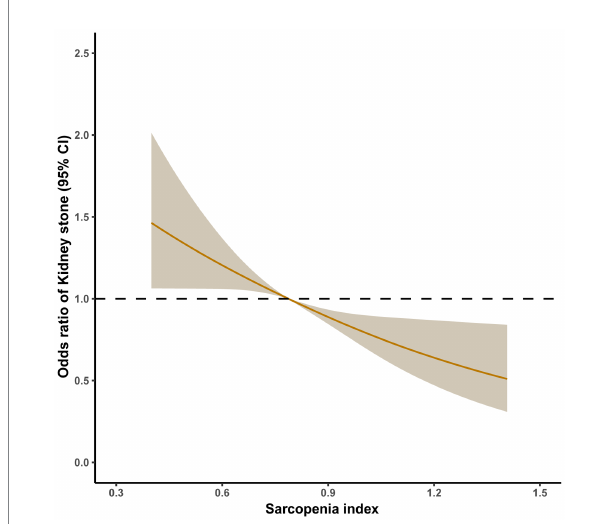
FIGURE 2 Relative risk for kidney stones based on sarcopenia index before PSM. The shaded areas represent upper and lower 95% CIs. Adjustment factors are as same as which presented in extended model 4. Restricted cubic spline (RCS) plot of the association between sarcopenia index and kidney stones. The solid and dashed lines represent the odds ratios and 95% confidence intervals.